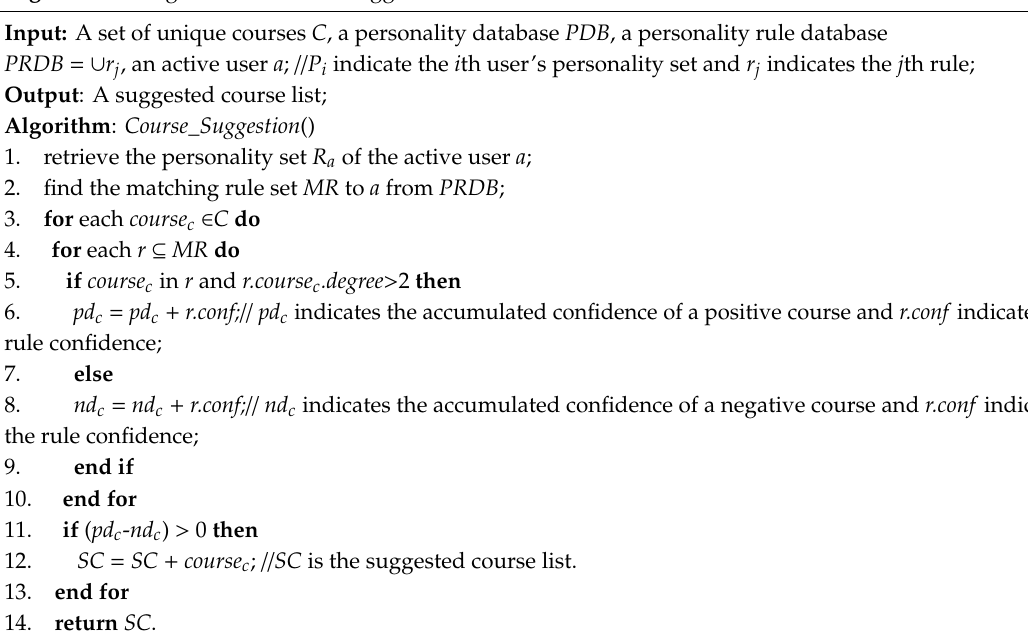
Algorithm 1. Algorithm of course